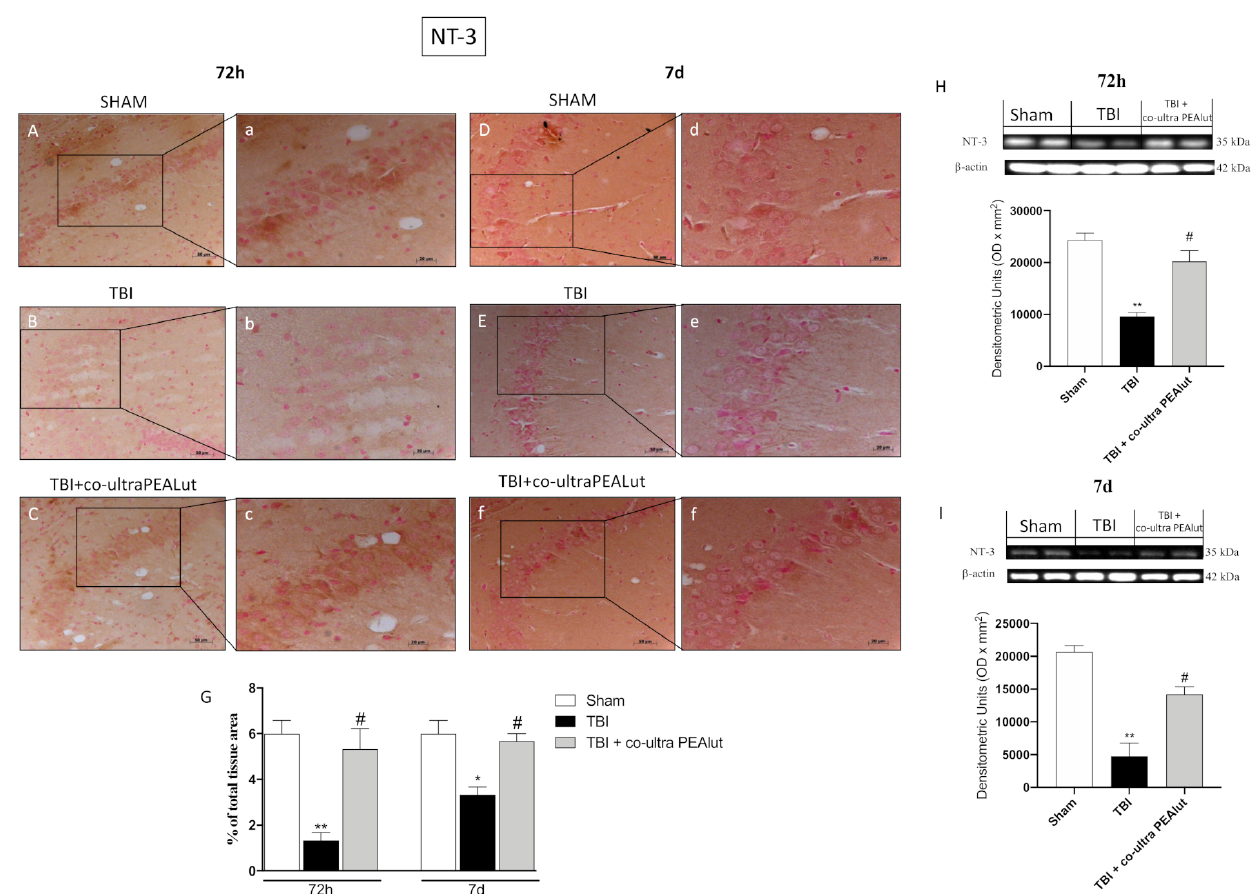
Figure 8. Effect of co-ultra PEALut on NT-3 expression. Co-ultra PEALut administration increased positive staining for NT-3 in a manner comparable to sham 72 h after TBI ( C , G ) and much more at 7 d ( F , G ). TBI mice showed a reduction in positive NT-3 staining for both 72 h and 7 d ( B , E , respectively, G ) compared to sham mice ( A , D , G ). Data were confirmed by Western blot analysis ( H , I ). For IHC analyses, the reaction was revealed by a chromogenic substrate (DAB), and counterstaining with Nuclear Fast Red. For a graphic display of the densitometric analyses, the percent of positive staining (DAB brown staining) was measured by computer-assisted color image analysis. The percentage area of immunoreactivity (determined by the number of positive pixels) was expressed as percent of total tissue area (red staining) within five random fields at a 40 × magnification. Data are expressed as Mean ± SEM from N = 20 mice for each group. One-way ANOVA test. * p < 0.05 vs. respective Sham; ** p < 0.01 vs. respective Sham; # p < 0.05 vs. respective TBI. Scale bar = 0.5 mm ( H – M ) and 20 µ m ( h – m ) for higher magnification (F 72h = 15.64 and F 7d = 11.4).